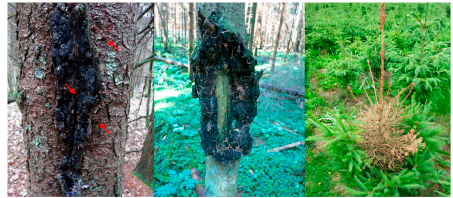
Figure 1. Damage caused by Neonectria fuckeliana on Norway spruce ( Picea abies ) in the Nordic countries: dark necrotic canker wounds on trees in a Norwegian forest stand ( left and middle , red arrows point towards clusters of perithecia of N. fuckeliana in or around the canker wound), and top-dieback including several branch whorls in a Swedish Christmas tree field ( right ). Photos: Martin Pettersson.